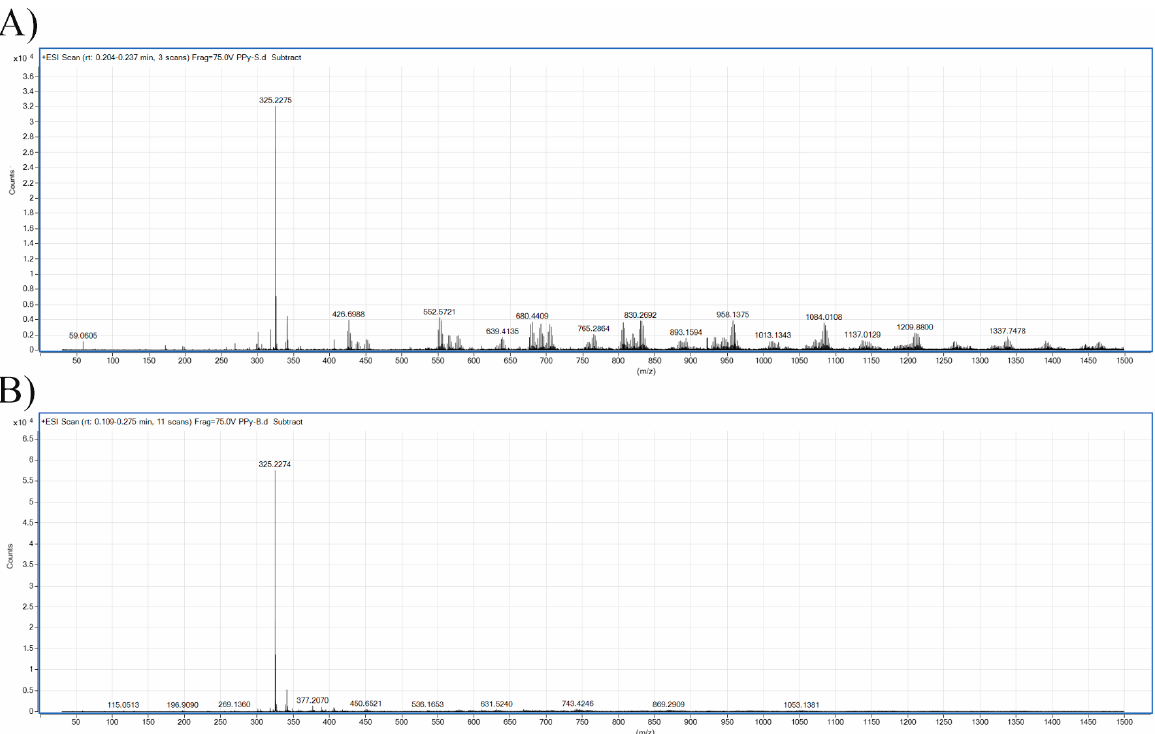
Figure 8. Positive-ion ESI-MS spectrum of polypyrrole extract; ( A ) polypyrrole salt, ( B ) polypyrrole base.